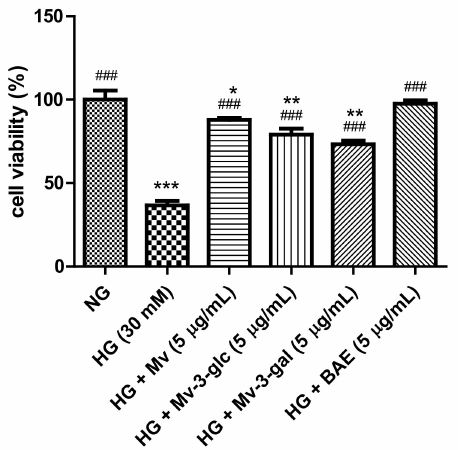
Figure 1. E ff ects of malvidin (Mv), malvidin-3-glucoside (Mv-3-glc), malvidin-3-galactoside (Mv-3-gal), and blueberry anthocyanin extract (BAE) on cell viability in human umbilical vein endothelial cells (HUVECs) exposed to high glucose for 24 h. Bars represent mean values ± SD ( n = 3). *, **, and *** indicate p < 0.05, p < 0.01, and p < 0.001, respectively, compared with the control (normal-glucose group, NG); ### indicates p < 0.001 compared with the high-glucose (HG) model.